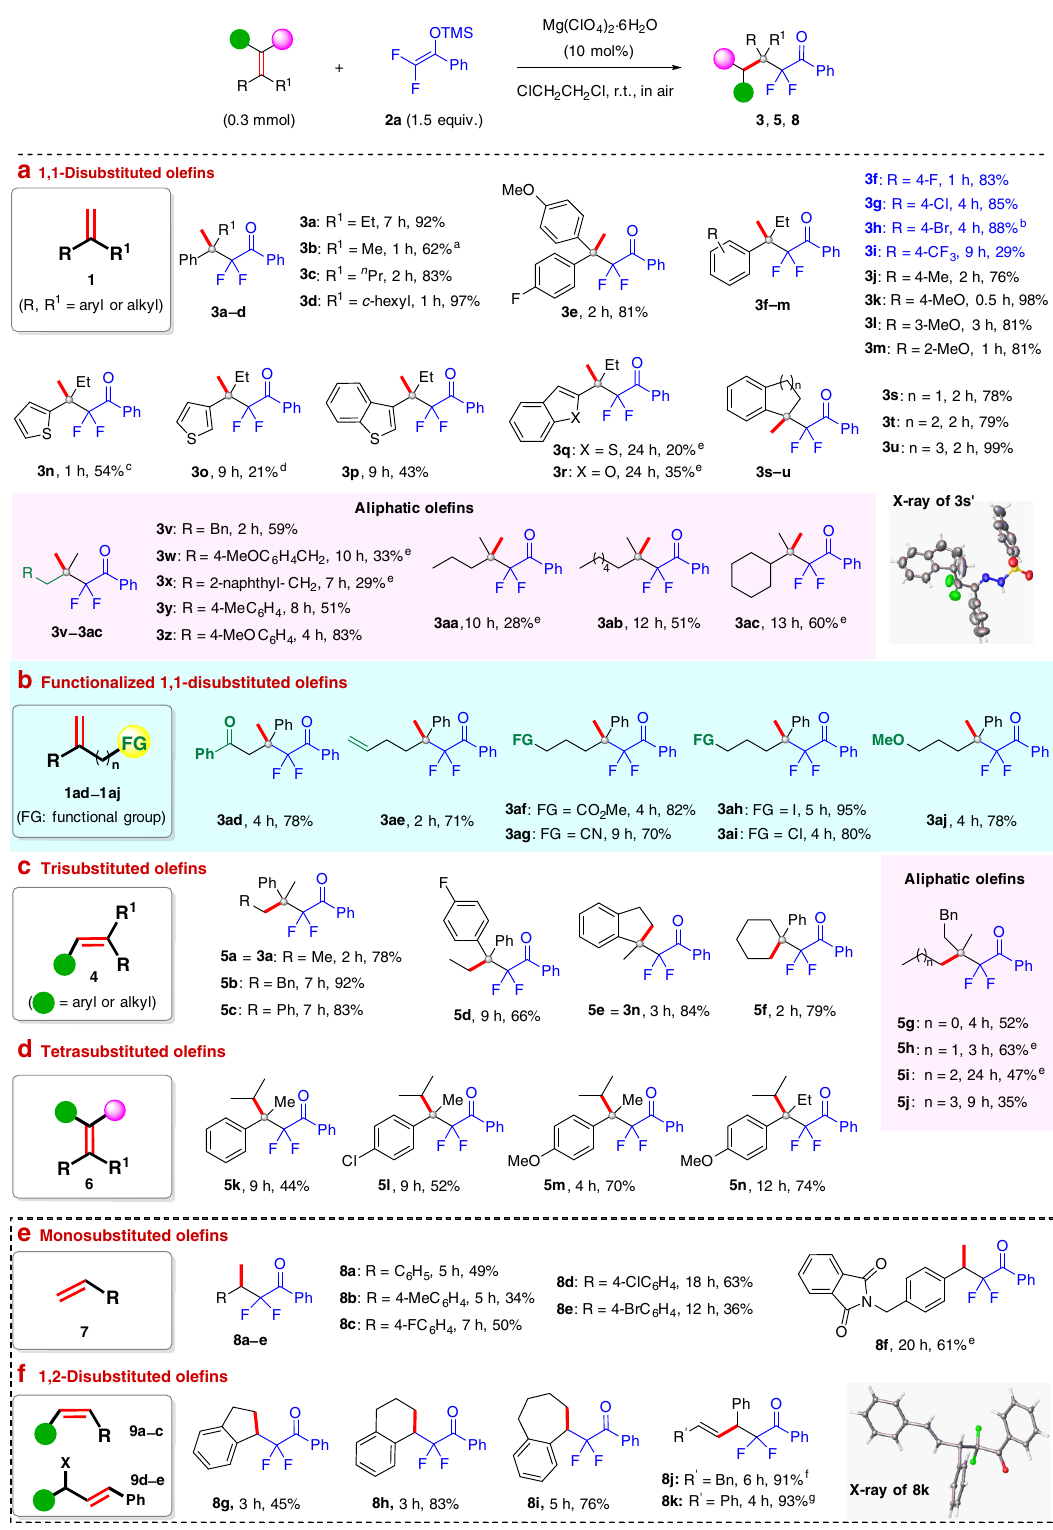
Fig. 3 Scope of the Markovnikov hydrodi fl uoroalkylation with respect to different alkenes. The structure of each numbered alkene is shown in the Supplementary Information. Reaction conditions: alkenes (0.3 mmol), 2a (0.45 mmol), Mg(ClO 4 ) 2 ·6H 2 O (10 mol%), and ClCH 2 CH 2 Cl (3 mL), in air at room temperature. a In all, 3 mol% Mg(ClO 4 ) 2 ‧ 6H 2 O, 3 equiv. 2a . b At 50 °C. c In all, 5 mol% Mg(ClO 4 ) 2 ‧ 6H 2 O, 3 equiv. 2a . d In all, 1 mol% Mg(ClO 4 ) 2 ‧ 6H 2 O, 3 equiv. 2a . e In all, 20 mol% Mg(ClO 4 ) 2 ‧ 6H 2 O, 3 equiv. 2a . f ( E )- N -(1,4-diphenylbut-3-en-2-yl)-4-methyl benzenesulfonamide 9d was used. g ( E )-((1,3-diphenylallyl)oxy) trimethylsilane 9e was